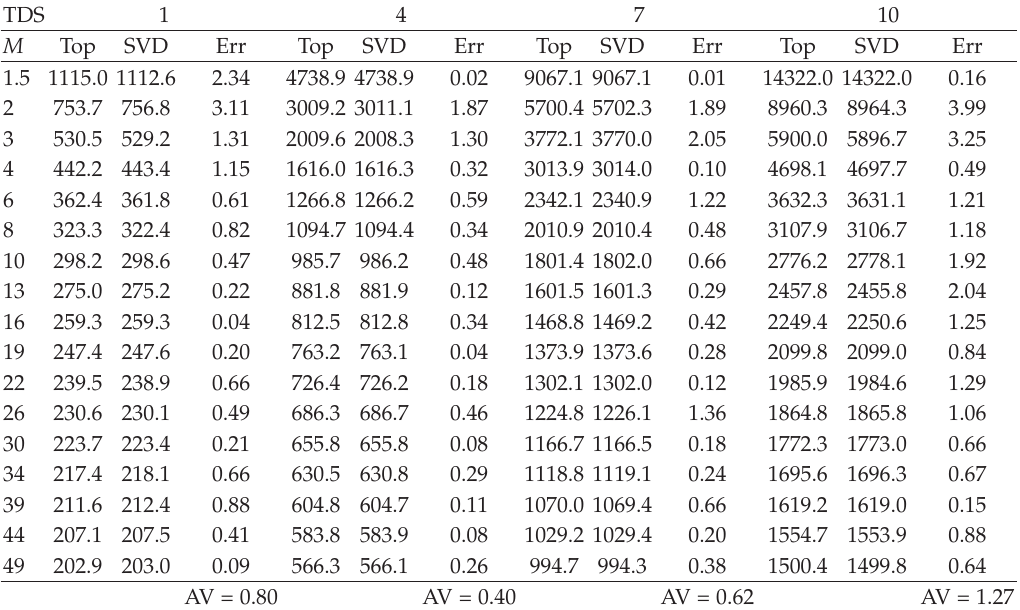
Table 2: The curve-fitting errors of 17 actual operating times for each TDS of the IAC51 relay in